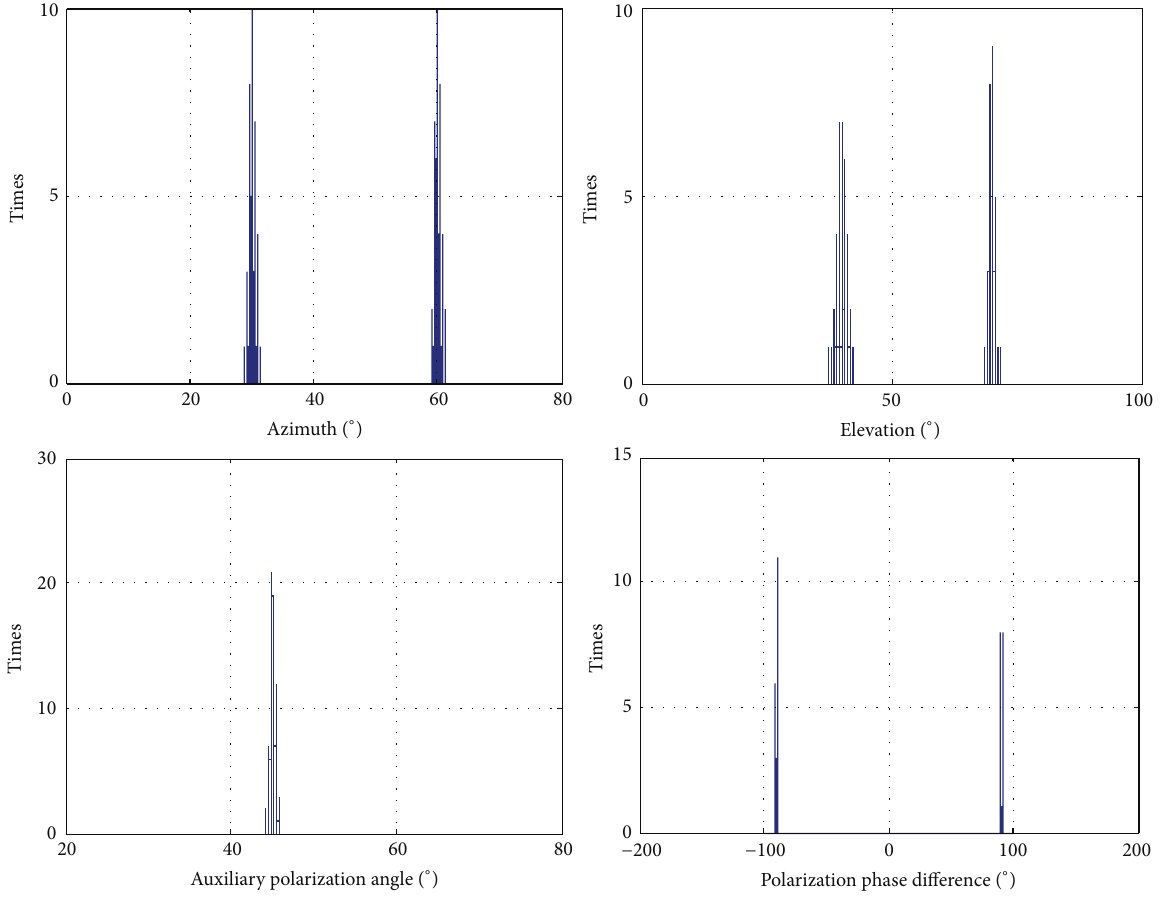
Figure 3: The estimation results of two targets with 500